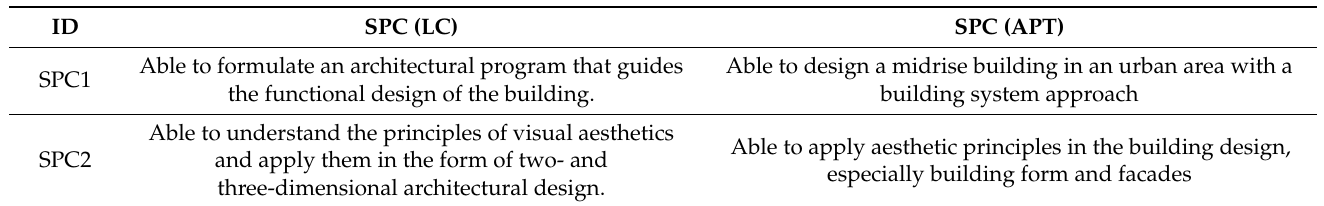
Table 2. Student Performance Criteria (SPC) of LC and APT